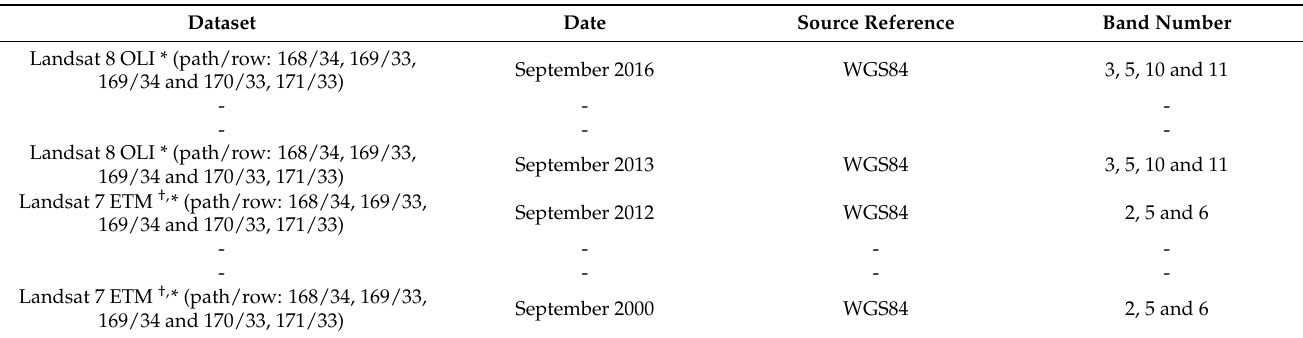
Table 1. Landsat image data.